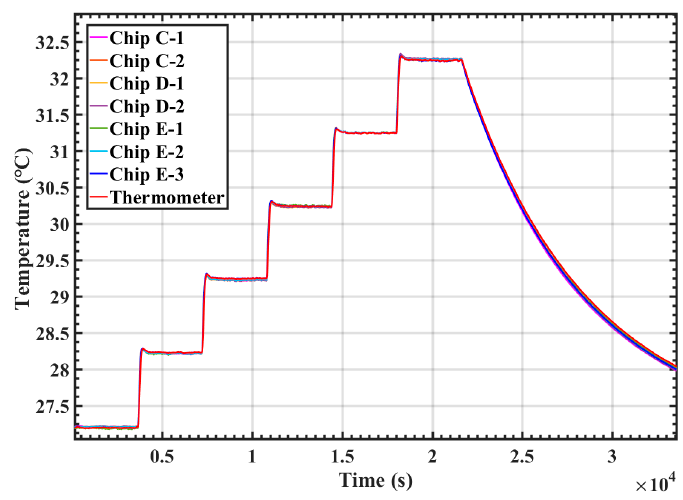
Figure 6. Comparison of temperature outputs of the proposed temperature sensors after calibration with the standard thermometer.